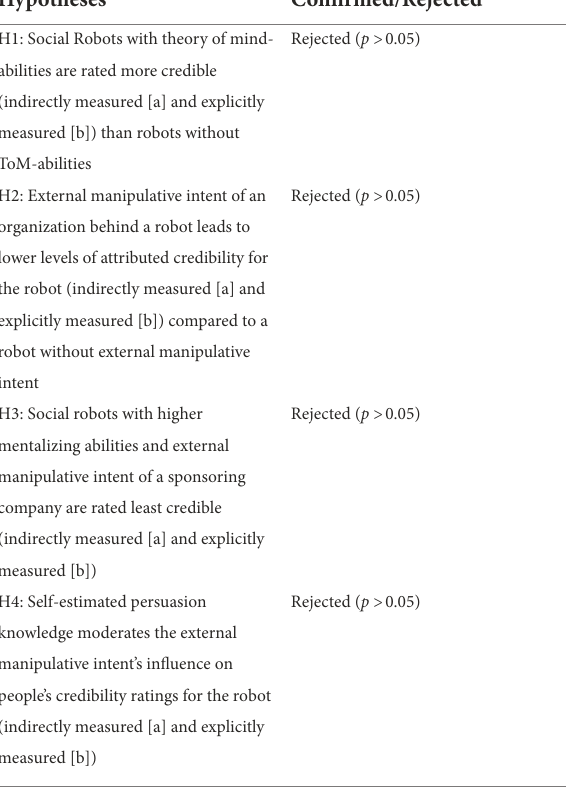
TABLE 5 Summary of results for the tests of